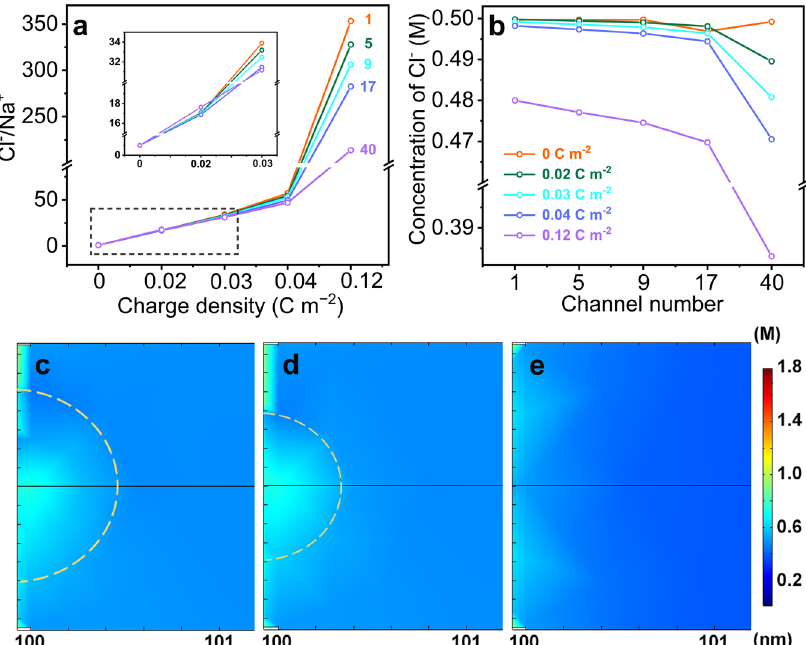
Fig. 4 Numerical simulation results. The impact of charge and pore densities (orange, olive, cyan, blue, violet: 1, 5, 9, 17, and 40 channels, respectively) on a the Cl − /Na + ratio at the mouth of the low-concentration side (inset: enlarged section of the black rectangle), b the distributions of Cl − at the entrance of the nanochannels contacted with 0.5 M NaCl, and ( c – e ) representative Cl − mapping at the entrance of pore channels with a charge density of 0.12 C m − 2 and various channel densities for 1, 9, and 40 channels, respectively.